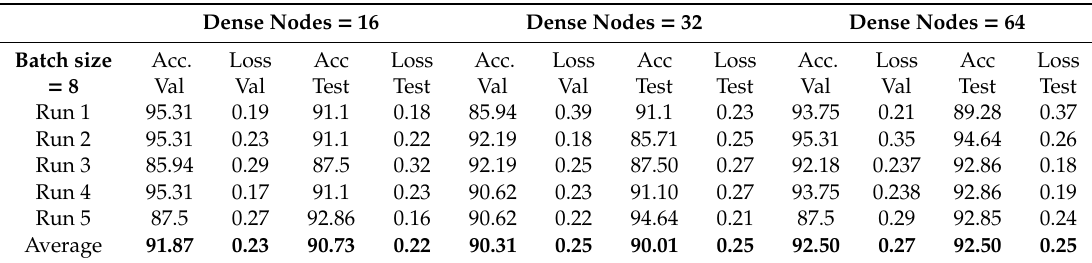
Table 6. CNN model (epochs = 200, pixel = 256 × 256, conv (8- > 16- > 32), dropout = 0.7) runs for di ff erent dense nodes. Dense Nodes = 16 Dense Nodes = 32 Dense Nodes = 64 Batch size = 8